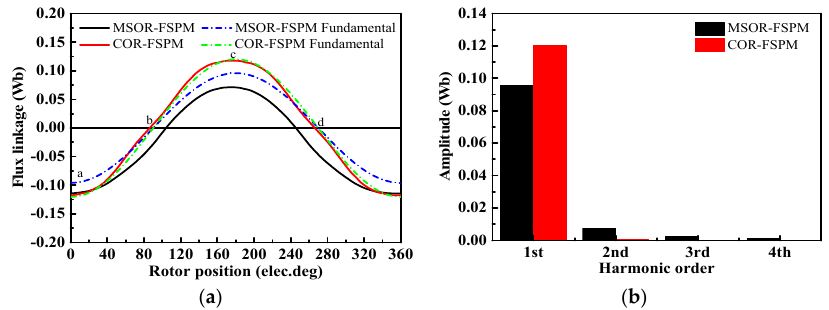
Figure 18. No-load flux linkage waveforms and FFT results of no-load flux linkage: ( a ) No-load flux linkage waveforms of phase A; ( b ) FFT results of phase A no-load flux linkage. The electromagnetic torque waveforms calculated directly by Maxwell 2D are shown in Figure 19.